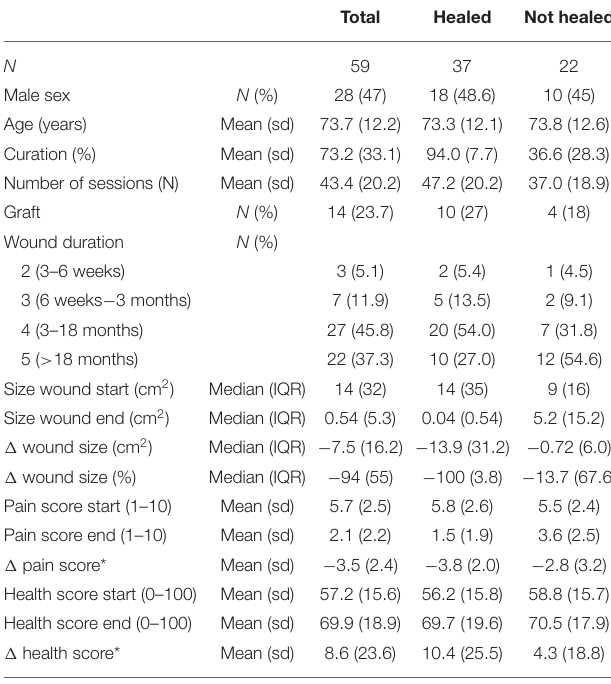
TABLE 1 | General description of the